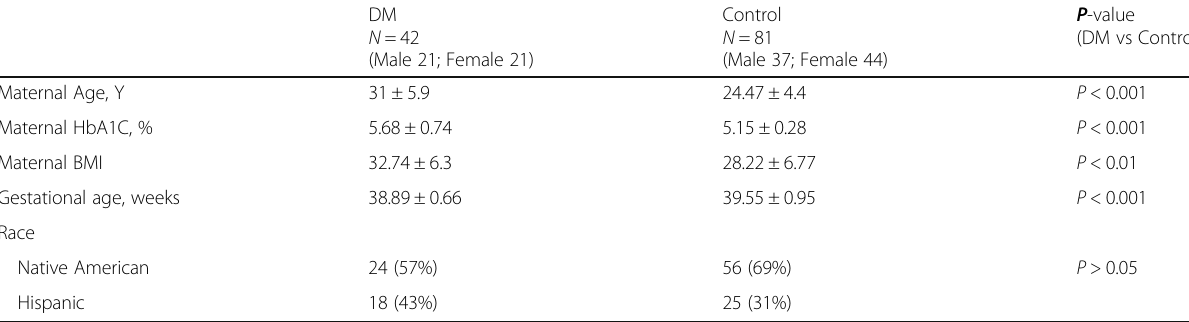
Table 1 Characteristics of research subjects providing cord blood samples